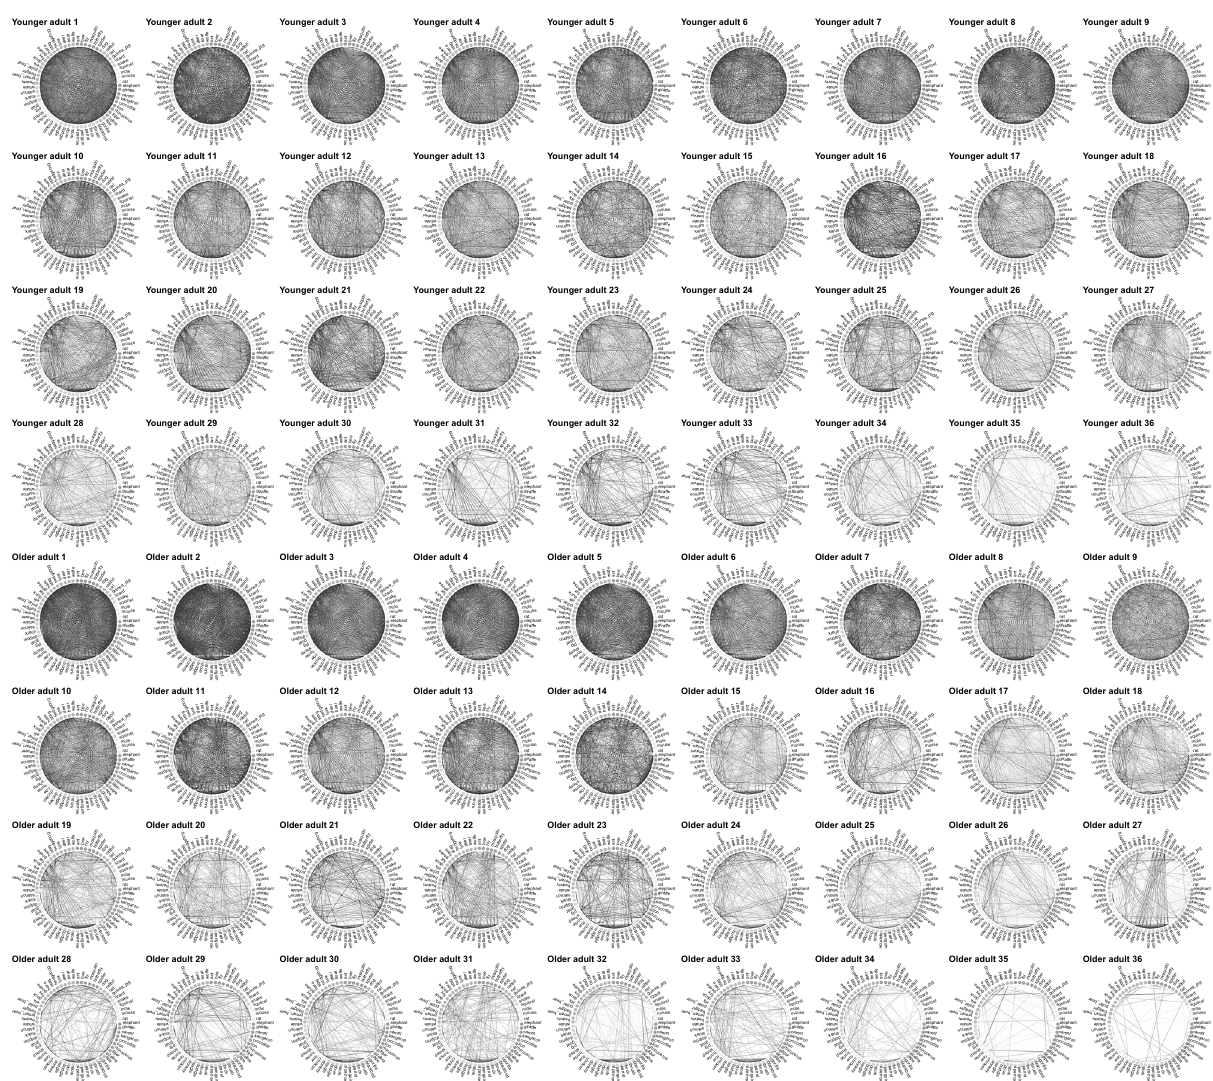
Figure 4. Similarity rating networks. Each individual plot shows the network of one individual under w min = .1 . The first four rows show the networks of younger adults, the bottom four rows those of older adults. Please note that networks are ordered by network strength to facilitate a visual comparison of between- and within-group variability in network structure. Edges’ weights have been scaled according to w 2 to increase visibility. Nodes are ordered and colored according to ten animal categories. These are, starting at 0 ◦ , African animals (plus kangaroo), large apes, birds, farm animals, fish, forest animals, pets, reptiles, and rodents. Animals names were translated from